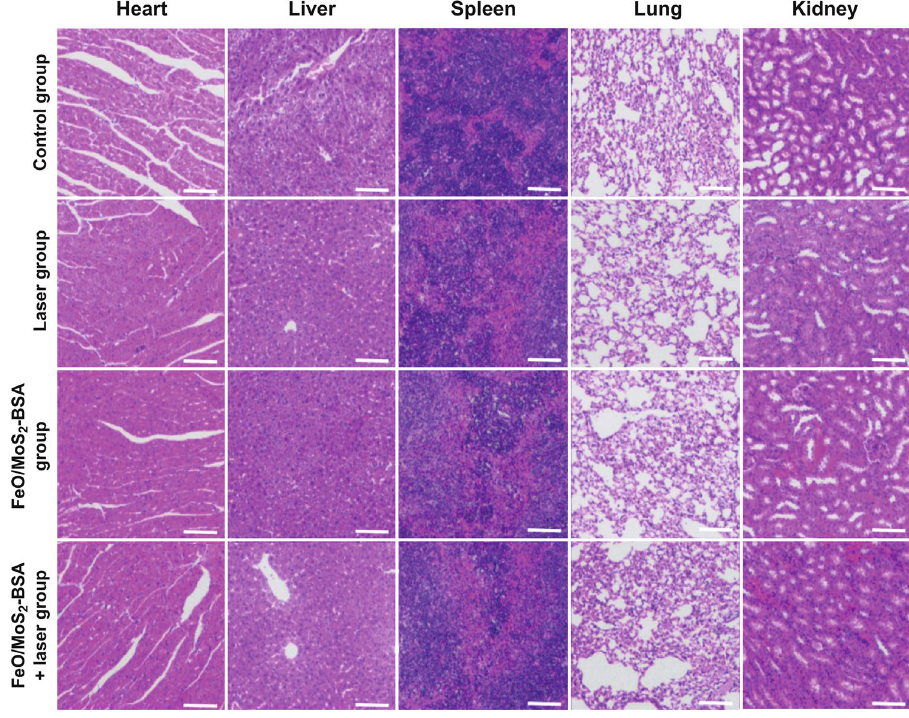
Fig. 5 H&E staining of organs (heart, liver, spleen, lung, and kidney) harvested from the mices after different treatments at 14th day (scale bars: 100